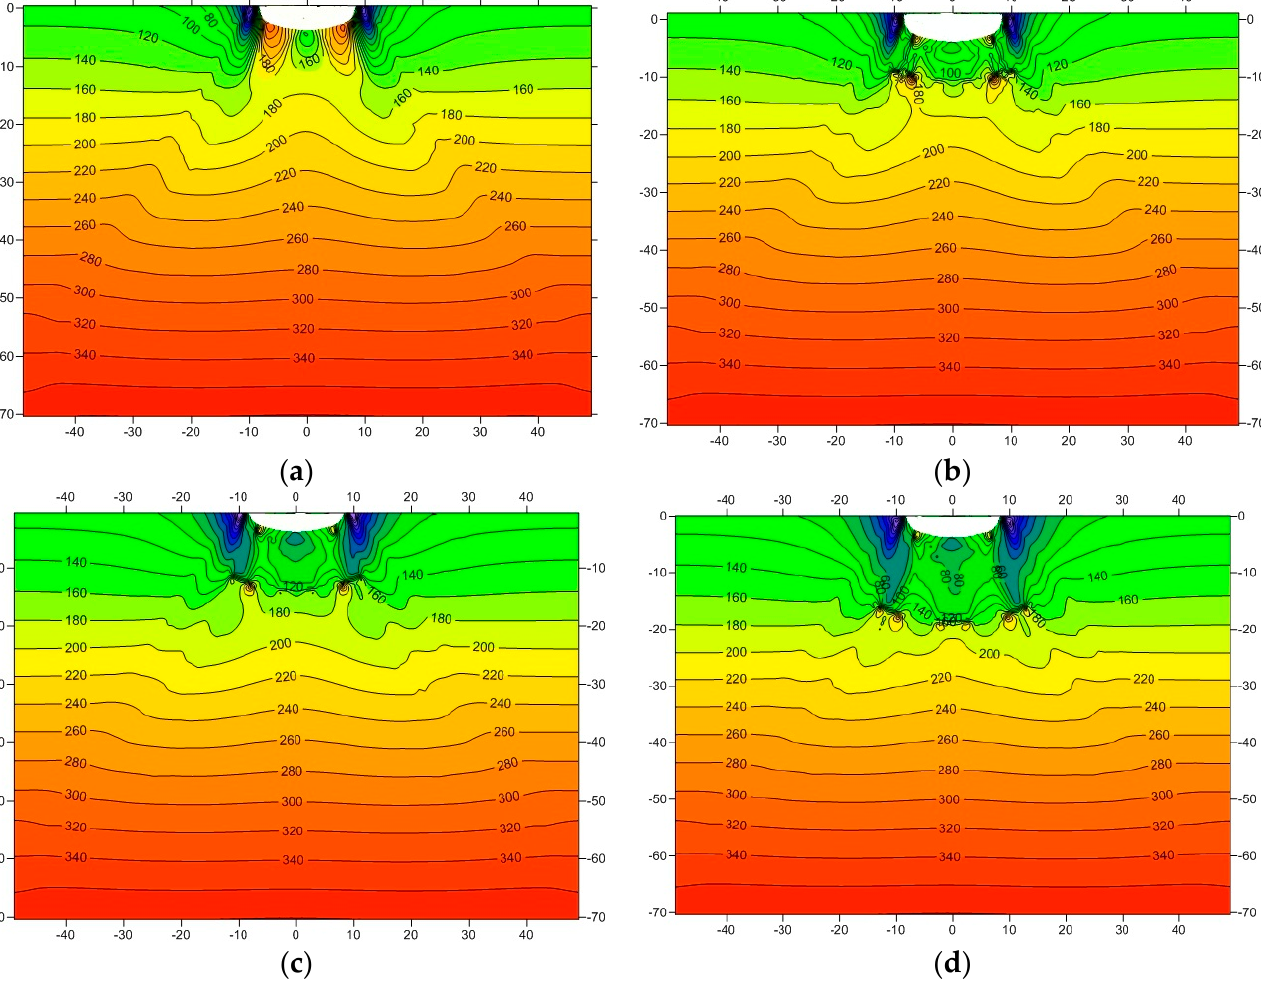
Figure 10. The additional stress of base: ( a ) No pile arrangement; ( b ) The pile length is 6 m; ( c ) The pile length is 11 m; ( d ) The pile length is 15 m.